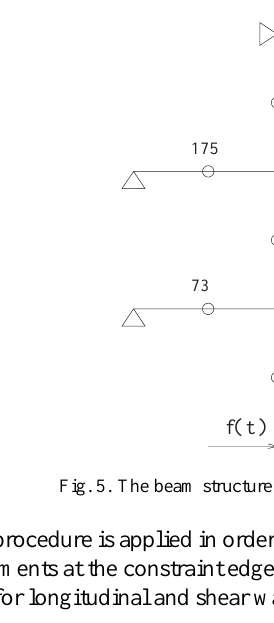
Fig. 4. Transmissibility taking into account damping effect for bending waves transmitted from node 30 to 73.